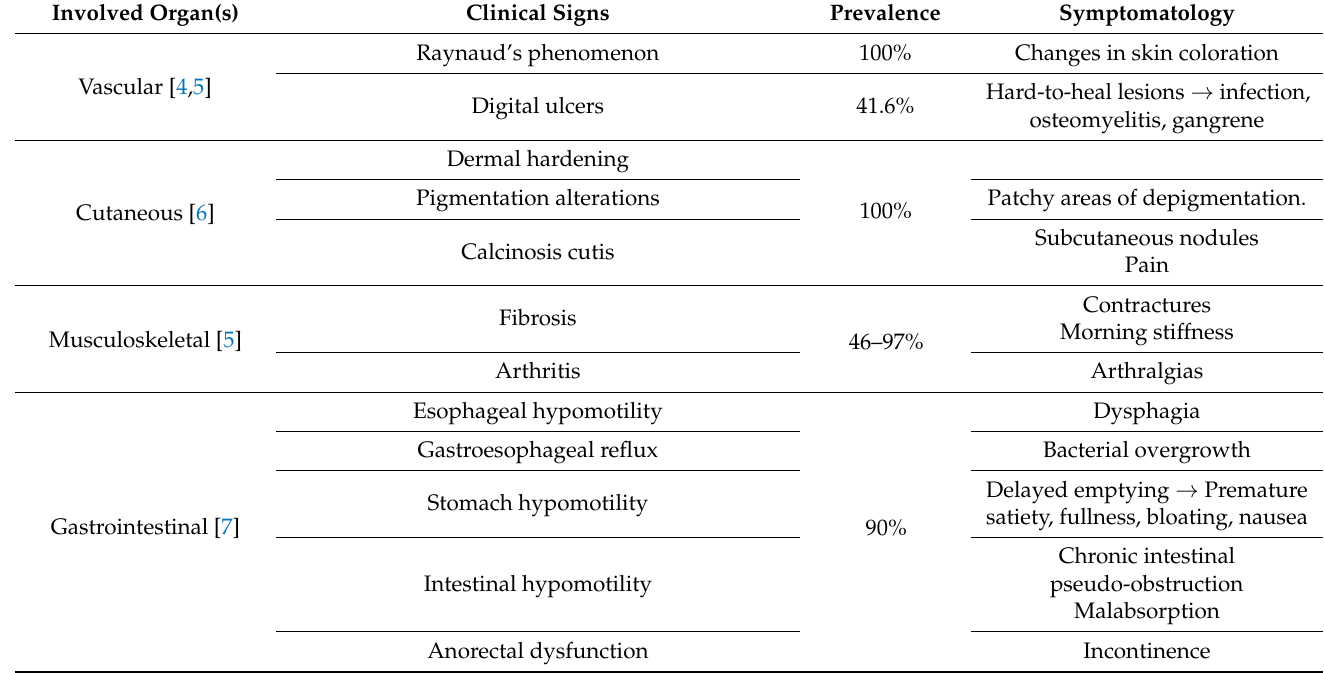
Table 1. Clinical signs, prevalence, and symptomatology in diffuse cutaneous systemic sclerosis (dcSSc). Involved Organ(s) Clinical Signs